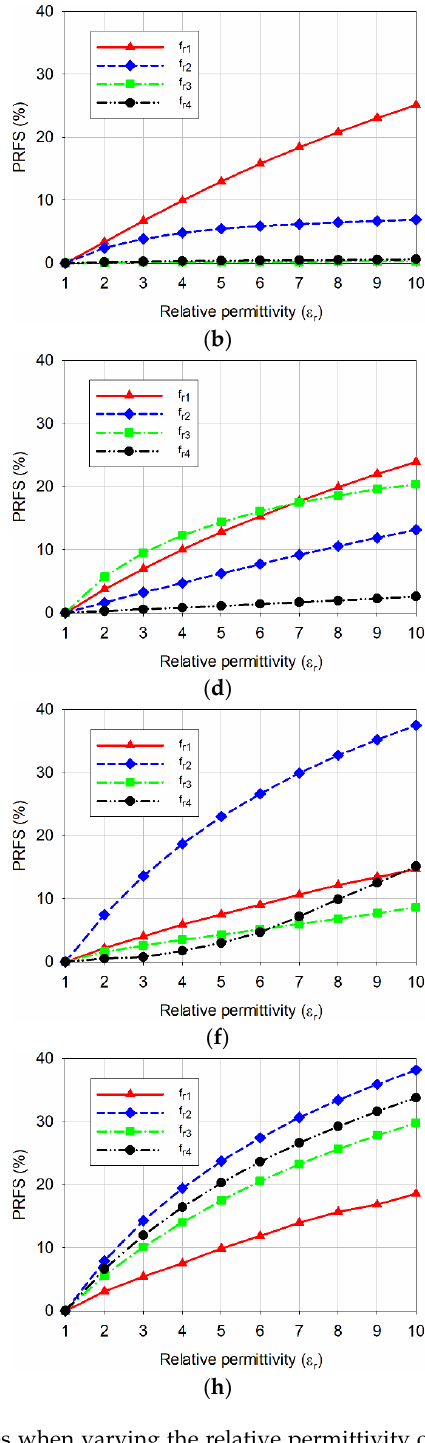
Figure 5. PRFS of the first four resonant frequencies when varying the relative permittivity of the MUT from 1 to 10 for: ( a ) the conventional MPSA without DGS; ( b ) the RS DGS-loaded MPSA; ( c ) the SR-CSRR-OS DGS-loaded MPSA; ( d ) the SR-CSRR-IS DGS-loaded MPSA; ( e ) the R-SR-CSRR DGS-loaded MPSA; ( f ) the DR-CSRR-RA DGS-loaded MPSA; ( g ) the DR-CSRR-CA DGS-loaded MPSA; and ( h ) the proposed scaled DR-CSRR DGS-loaded